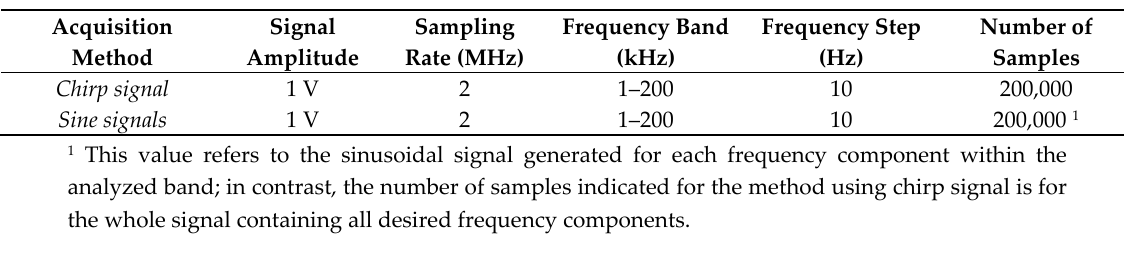
Table 1. Configuration parameters of impedance measurement